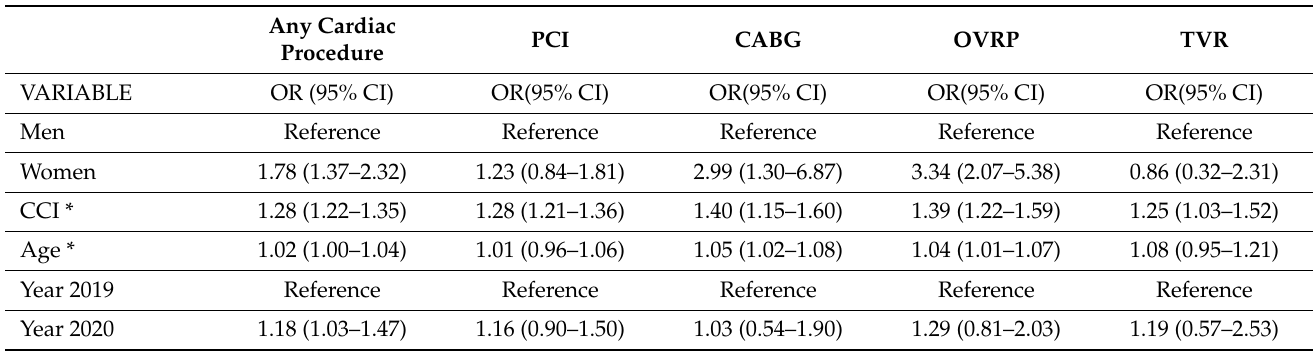
Table 4. Multivariable logistic regression models to assess the change from 2019 to 2020 and the variables associated with in-hospital mortality among people with chronic obstructive pulmonary disease who underwent any cardiac procedure, percutaneous coronary intervention (PCI), coronary artery bypass graft (CABG), open valve replacement procedures (OVRP), and transcatheter valve replacement